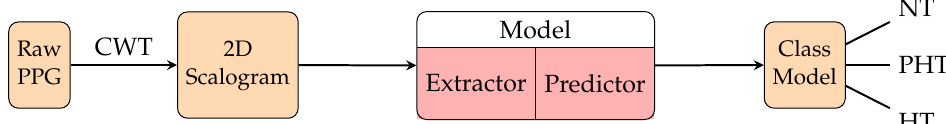
Figure 10. The structure of the algorithm in [131]. PPG signals are preprocessed by continuous wavelet transform (CWT) to produce two dimensional scalograms for identifying the low-frequency or fast-changing frequency components. These scalograms are converted into RGB images for the convolutional neural network pretrained by GoogLeNet. This model automatically extracts features in the scalograms to predict the BP categories: normotension (NT), prehypertension (PHT), and hypertension (HT).